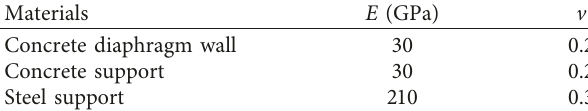
Table 1: Mechanical property parameters.